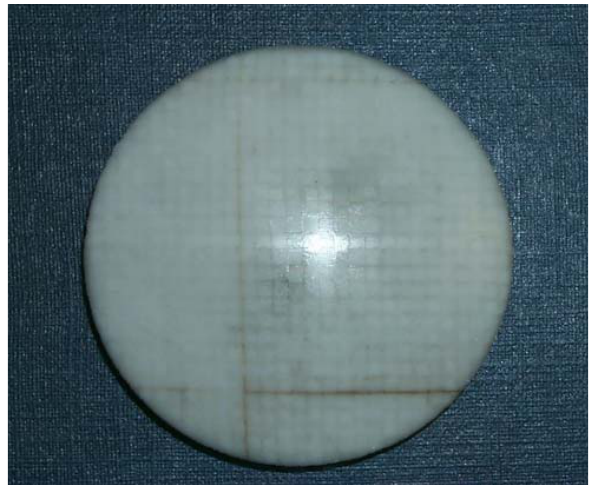
Fig. 4. The 46 mm diameter test optic. Fig. 4. The 46mm diameter test optic. The squares seen on the surface are multifibre boundaries. The areas with more distinct dis- colouration contain more significant multifibre errors. The cruci- form feature visible slightly right of centre is produced by light re- flected from the channel walls.